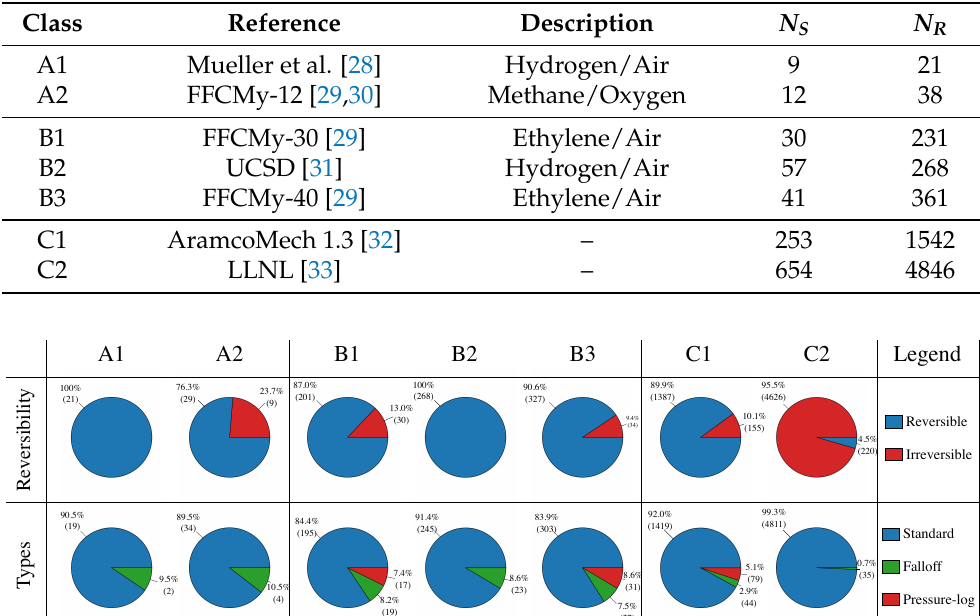
Table 1. List of mechanisms used throughout this work arranged in ascending order of N R . They are grouped into three classes based on N R for ease of reference. Class A is for smaller mechanisms ( N R = O ( 10 ) ), Class B for medium-sized mechanisms ( N R = O ( 100 ) ), and Class C for large mechanisms ( N R = O ( 1000 ) ). Note that the mechanism labeled C1 is unrelated to the jet fuel of the same name.